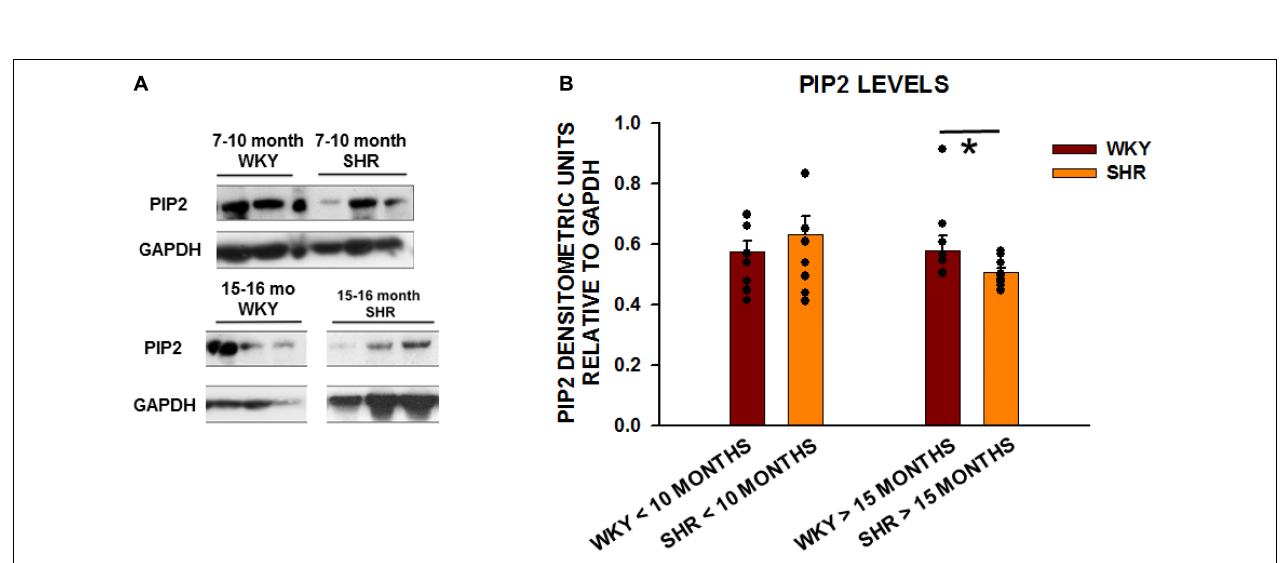
FIGURE 2 | PIP2 levels are reduced with age in SHRs in comparison to control WKY rats. (A) Expression of PIP2 from left ventricular tissue in two different age group of animals with young animals < 10 months of age (WKY n = 8 rats; SHR n = 6 rats) and old animals > 15 months (WKY n = 8 rats; SHR n = 9 rats). (B) Graph of relative protein expression normalized to GAPDH. Values indicated mean ± SEM here and in all subsequent experiments. Comparisons were made using an unpaired t -test. * p < 0.05.